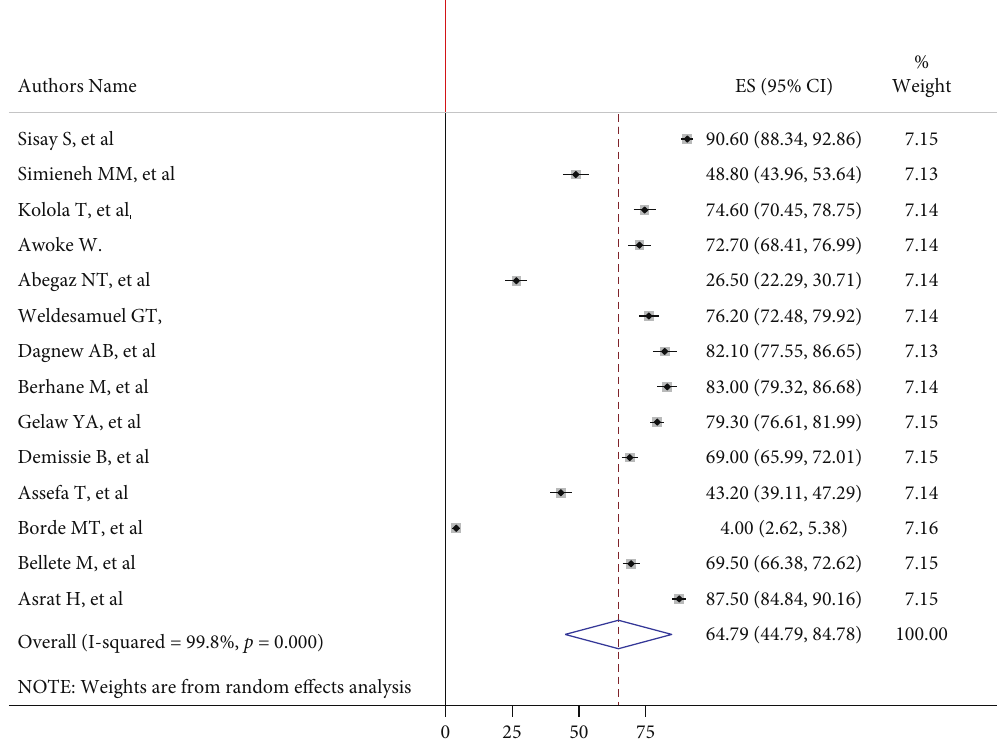
Figure 2: Forest plot showing pooled prevalence of mother ’ s care-seeking behavior for common childhood illnesses in